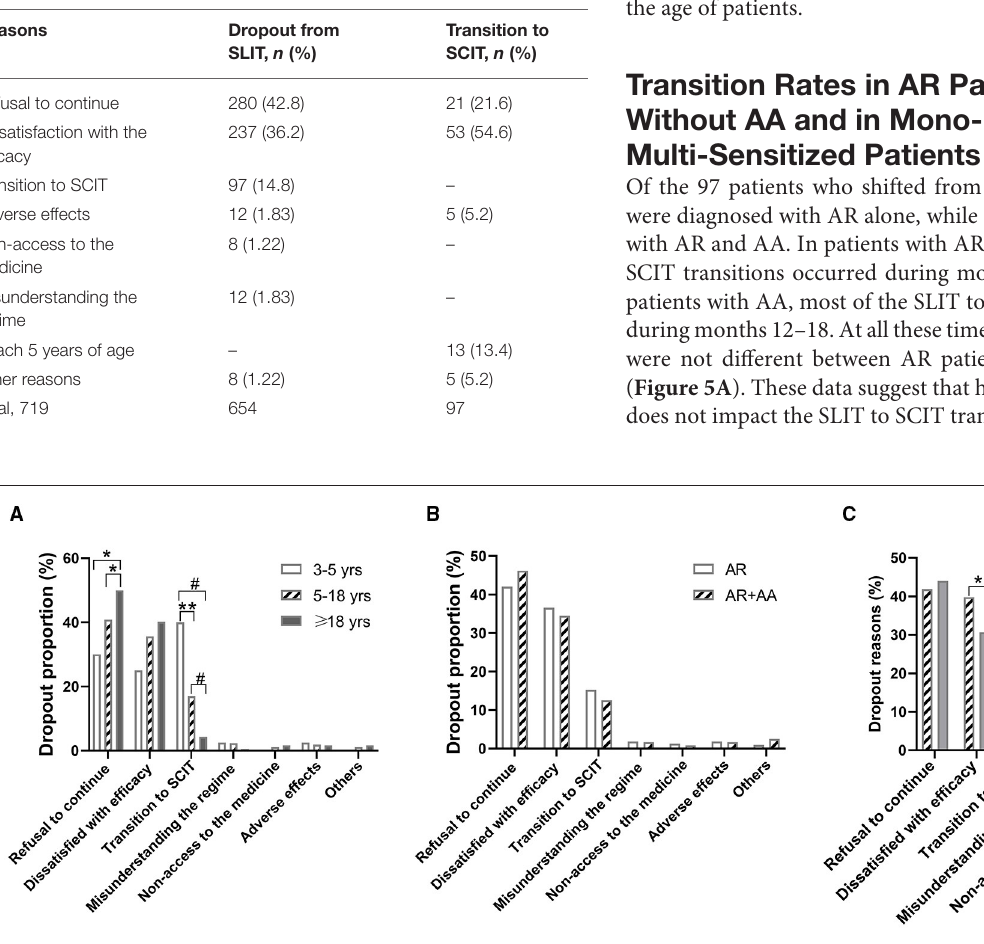
FIGURE 3 | Dropout reasons according to age, underlying diseases, and sensitization status. (A) Dropout reasons in different age groups. (B) Dropout reasons in allergic rhinitis (AR) patients with and without allergic asthma (AA). (C) Dropout reasons in patients sensitized to HDM alone (Mono) and patients sensitized to other aeroallergens in addition to HDM (Multi). * P < 0.05; ** P < 0.01; # P < 0.001.